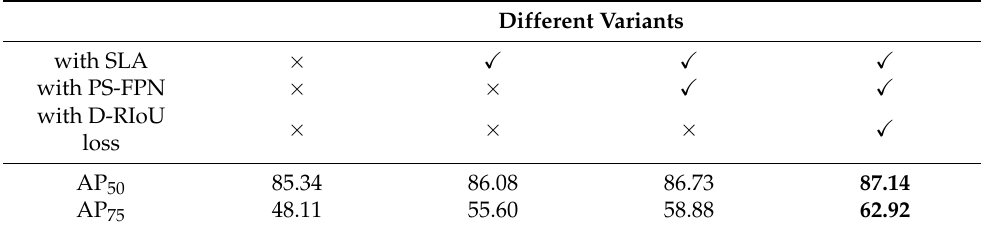
Table 1. Effects of the proposed components on HRSC2016